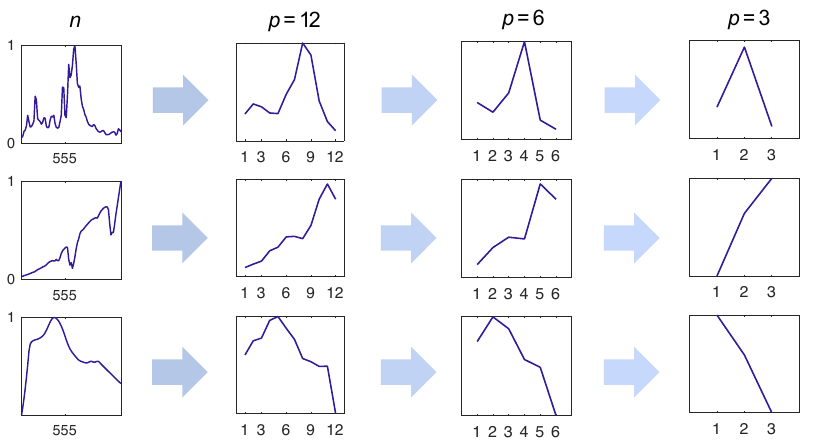
Figure 2. Unique identifying features of the signal are lost when the resolution of the sensor is decreased. Here, we show the effect of uniform sampling. Preserving unique features in the measured dimension is important for ensuring agreement between x (cid:48) and x